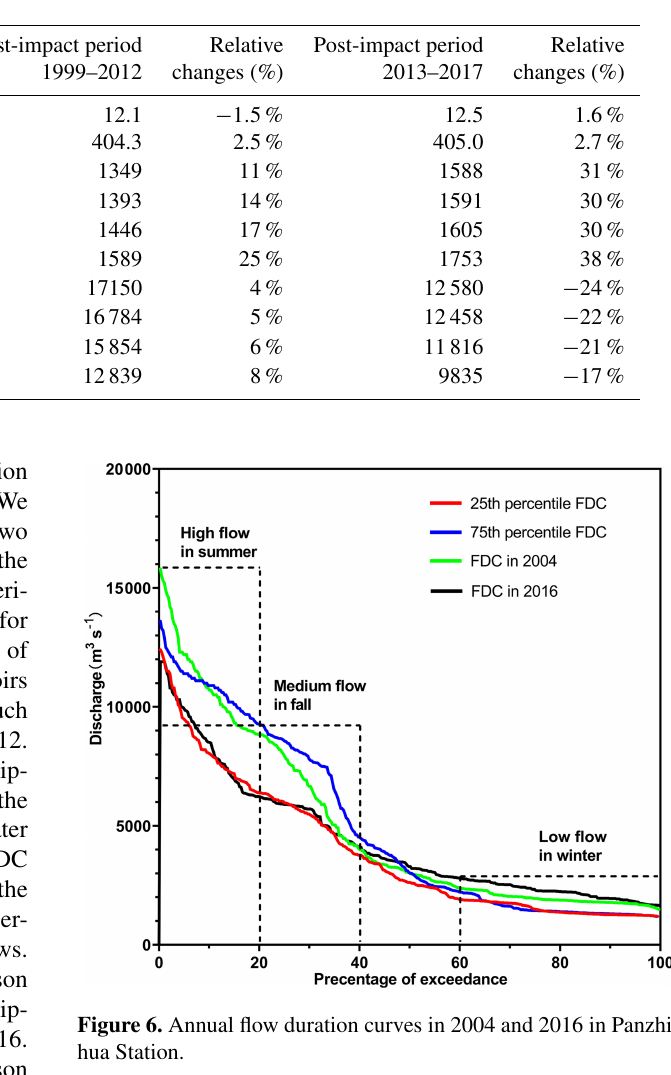
Table 7. Changes in the annual minimum and annual maximum flows between the periods 1966–1998, 1999–2012 and 2013–2017 in Pingshan Station.